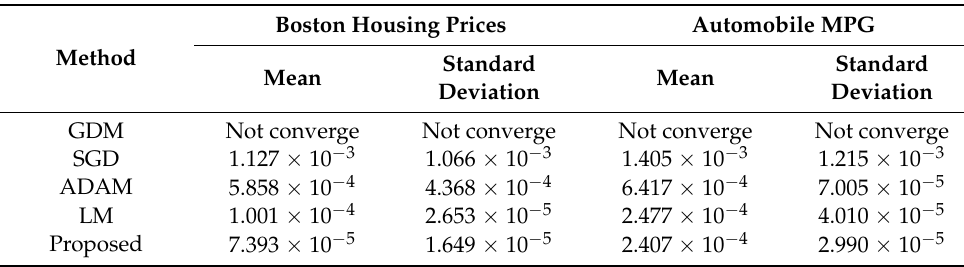
Table 3. Boston housing prices and automobile MPG training performances using early stopping (validation patient of 15)—training errors (MSE).